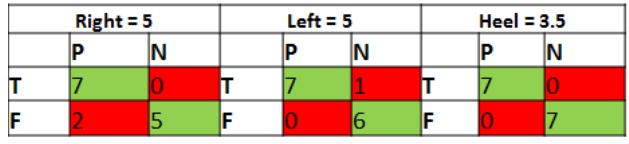
Table 6. Confusion matrix for the pressure sensors.